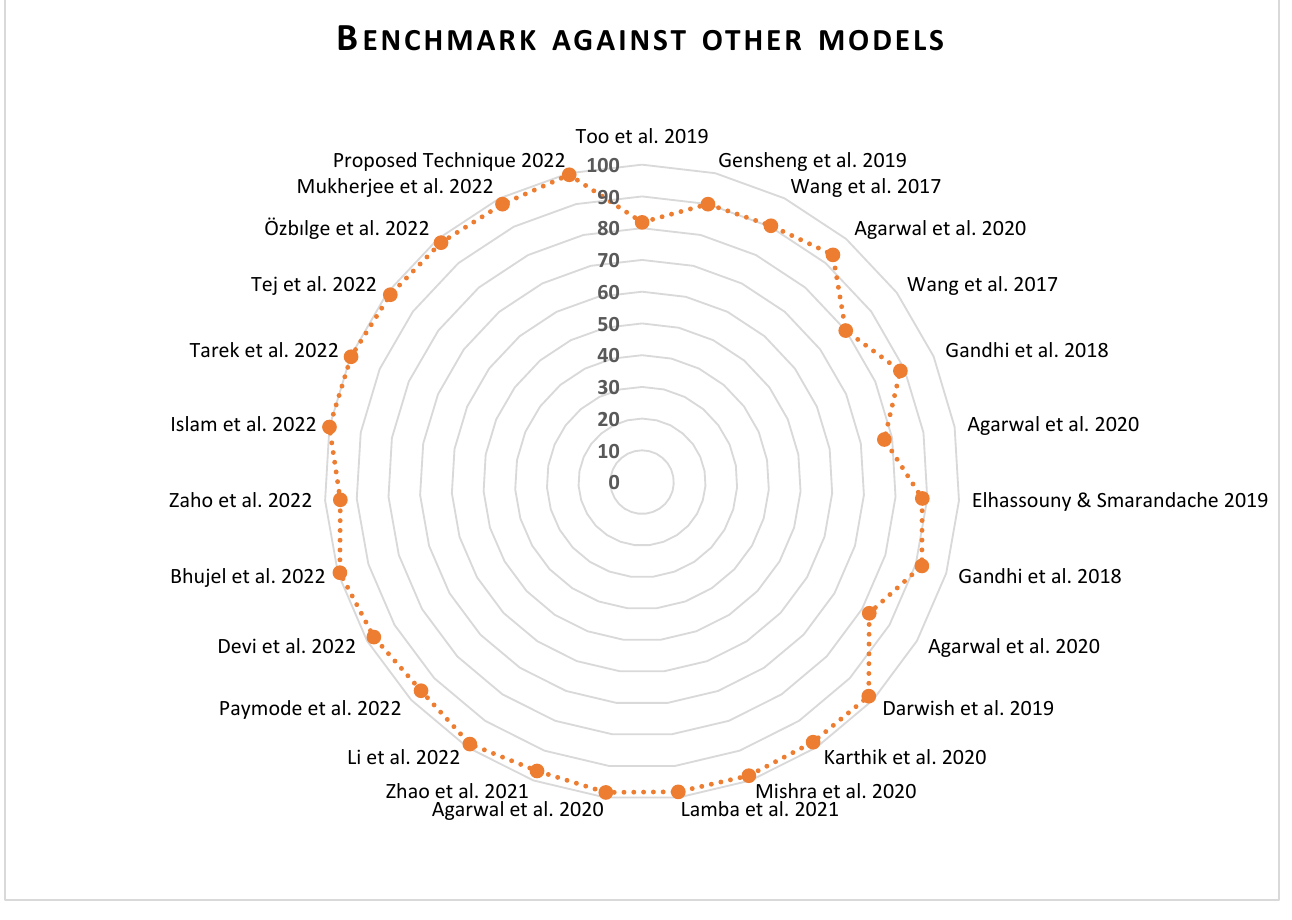
Figure 13. Benchmark against other models [27,47 – 49,58 – 74].